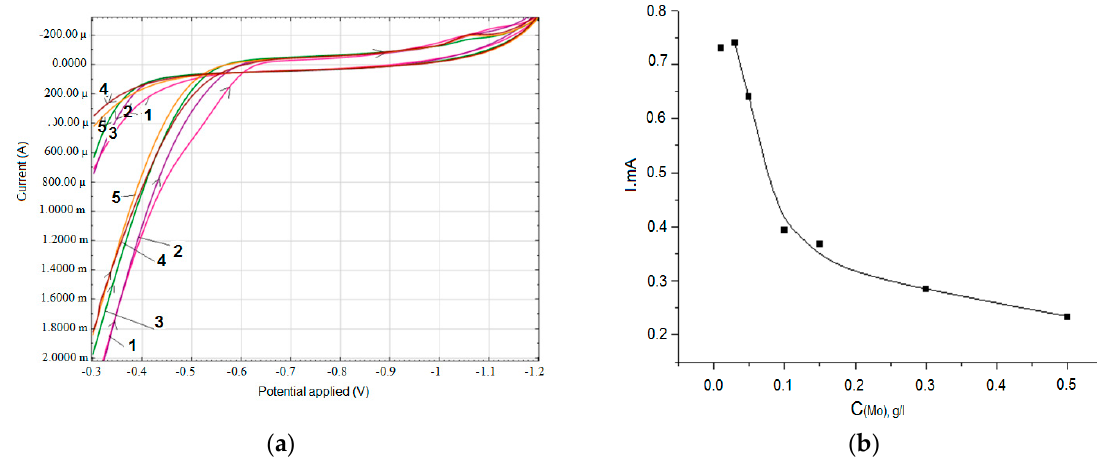
Figure 2. Volt–ampere curves of an iron electrode ( a ) and a change in the ionization current of the iron electrode ( b ) at different concentrations of Mo (VI). Electrolyte 0.3 M Na 2 SO 4 + 0.2 g/L Zr (IV) + Mo (VI) (g/L): 1—0.1; 2—0.3; 3—0.5; 4—1; 5—1.5.